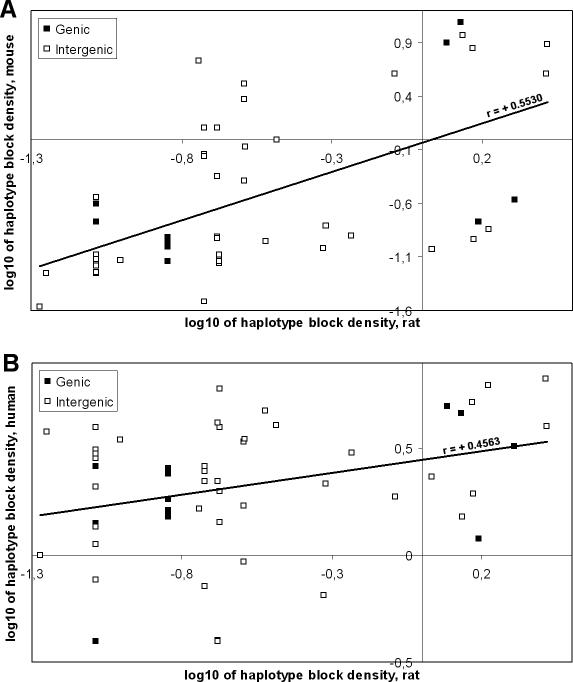
Comparison of the Haplotype Block Densities between Syntenic Regions of Rat, Mouse, and Human (Same Genome Segments as Shown in Figure 1)The scatter plots show log10 of the amount of haplotype blocks per 100-kb bin in rat (horizontal) against log10 of the amount of haplotype blocks seen in syntenic region of mouse (A) and human (B) genome (vertical). Data points for gene-containing and intergenic genomic bins are shown as closed and open blocks, respectively. Observed correlations of haplotype block densities are significant in linear (r = +0.5530; p < 0.0001 [A] and r = +0.4563; p = 0.0005 [B]) as well as in log-transformed space (r = +0.6795; p < 0.0001 [A] and r = +0.3209; p = 0.0180 [B]).